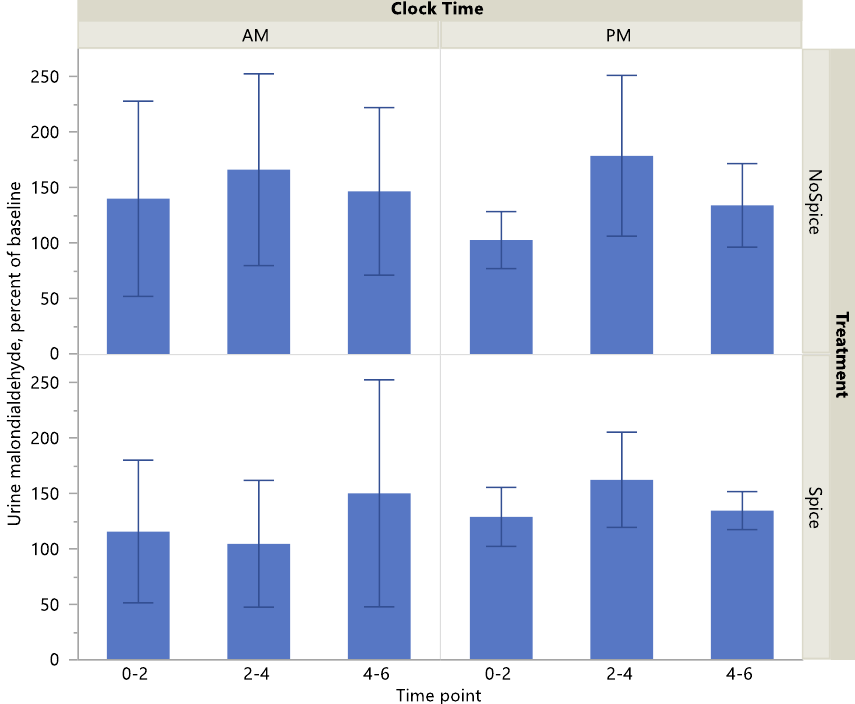
Figure 4. Urine malondialdehyde as percentage of baseline by treatment, clock time and time point. Values are means with standard deviation. There was no significant effect of treatment, clock time or time point.